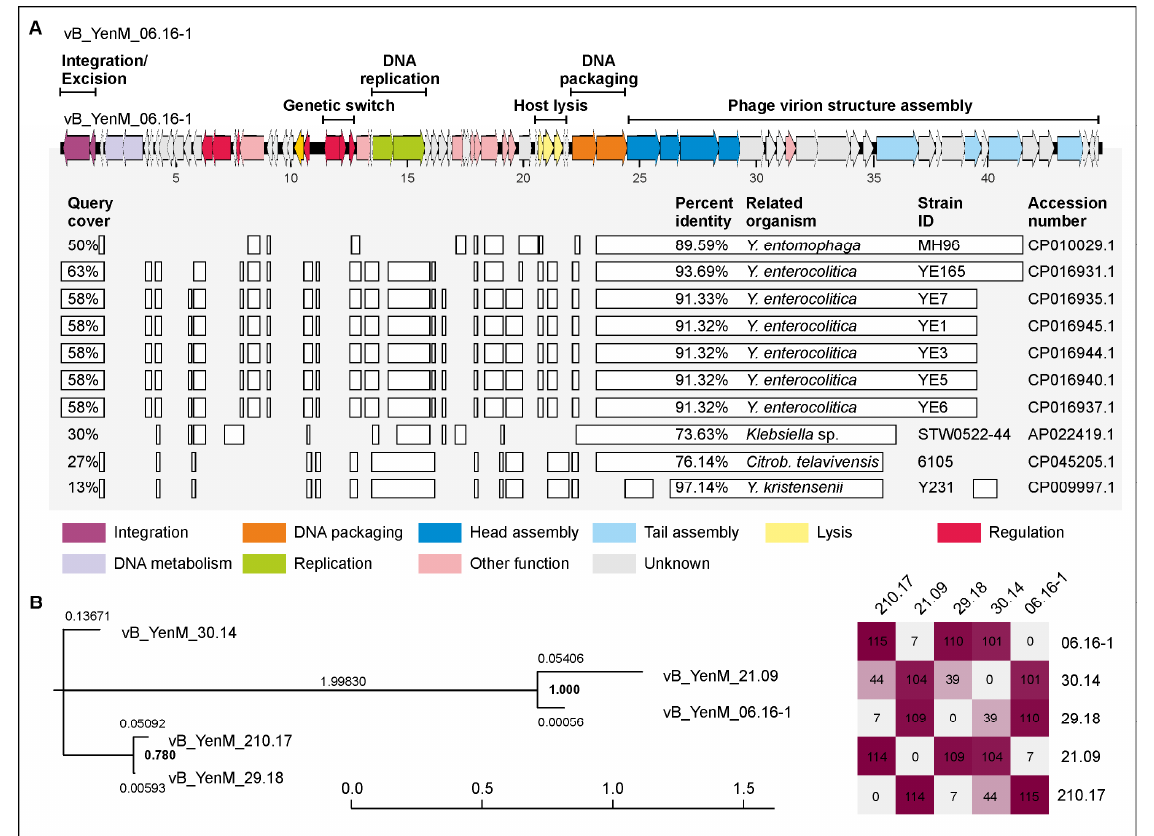
Figure 4. Gene map of vB_YenM_06.16-1 and its relationship to other prophages. ( A ) Gene map of the phage and identity values with other prophage sequences deposited in GenBank. White bars represent regions of high nucleotide similarity (>75%). ( B ) Phylogenetic tree (single nucleotide polymorphism (SNP)-based) of phages belonging to the vB_YenM_06.16-1 group. The scale bar represents the number of nucleotide substitutions per site. On the right, the numbers of single nucleotide variations between individual phage genomes are given. Citrob . telavivensis = Citrobacter telavivensis . Table 2. Attachment sites of the groups vB_YenM_06-16-1, vB_YenM_06-16-2 and vB_YenM_42-18.